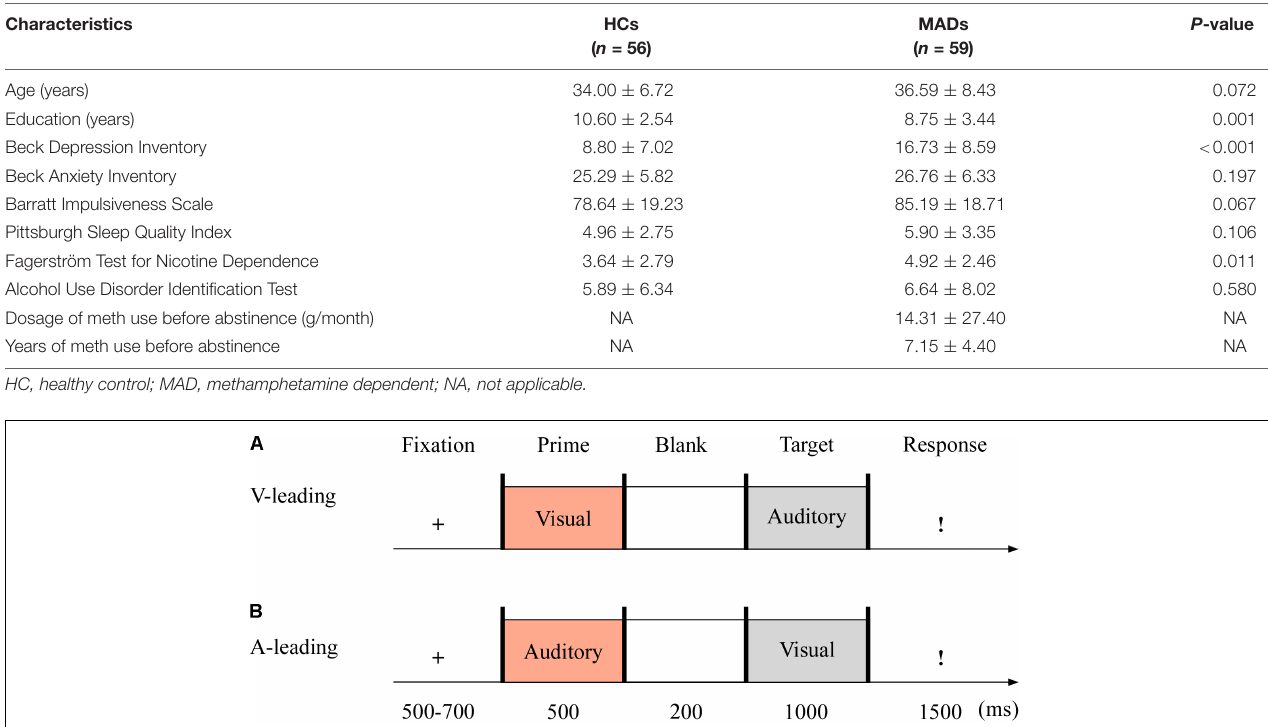
TABLE 2 | Demographic variables of the participants in Experiment 2 (mean ± SD).